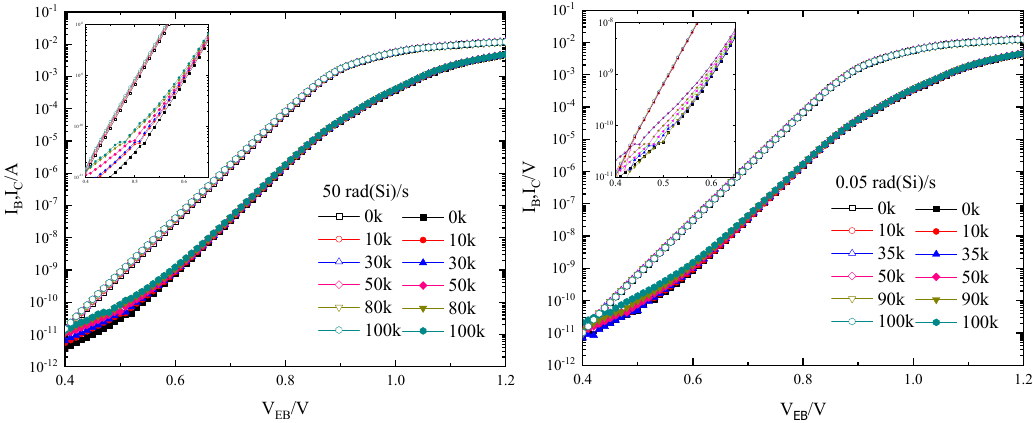
Figure 2. Gummel characteristics of a DPSA BJT before and after irradiation at the dose rate of 50 rad (Si)/s and 0.05 rad (Si)/s. V EB = emitter-base voltage; I C = collector current; I B = base current.